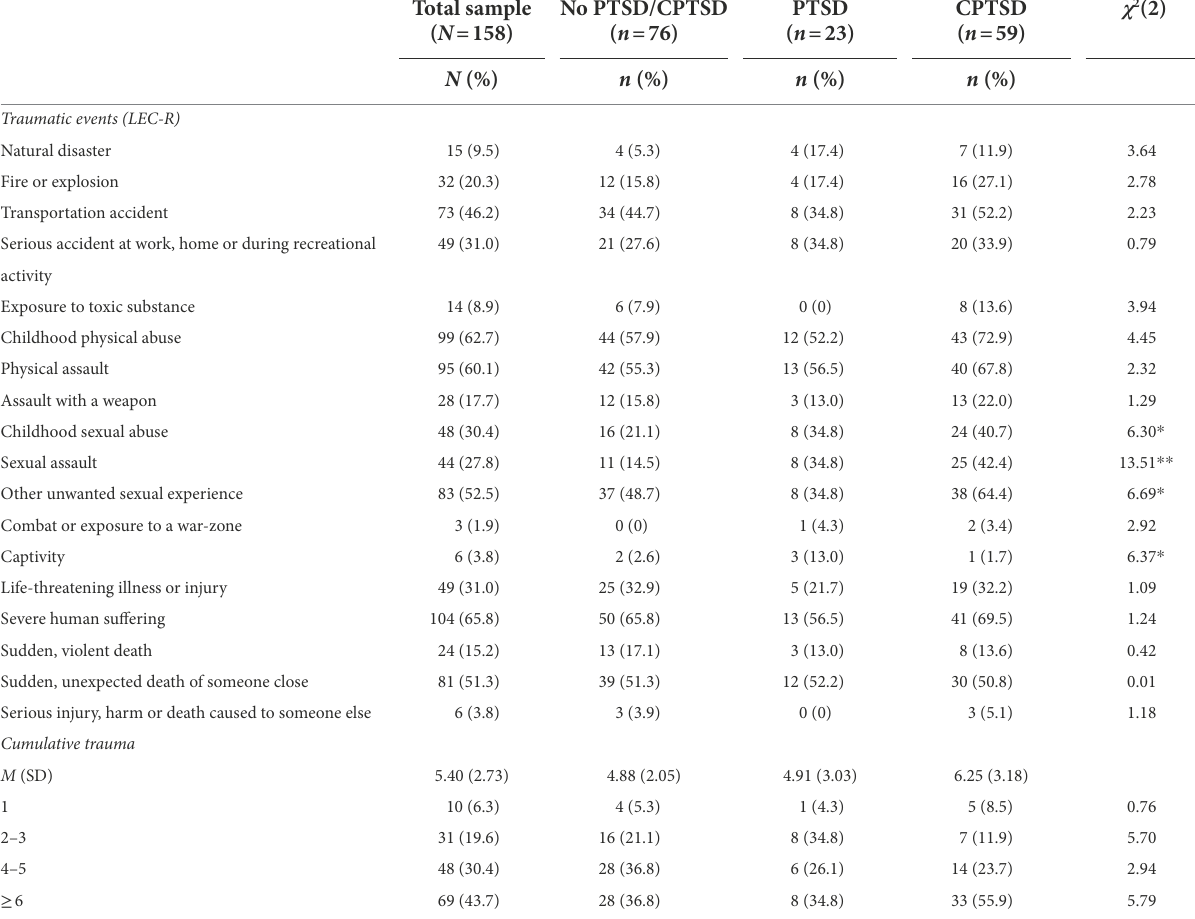
TABLE 1 Prevalence of traumatic events in the study